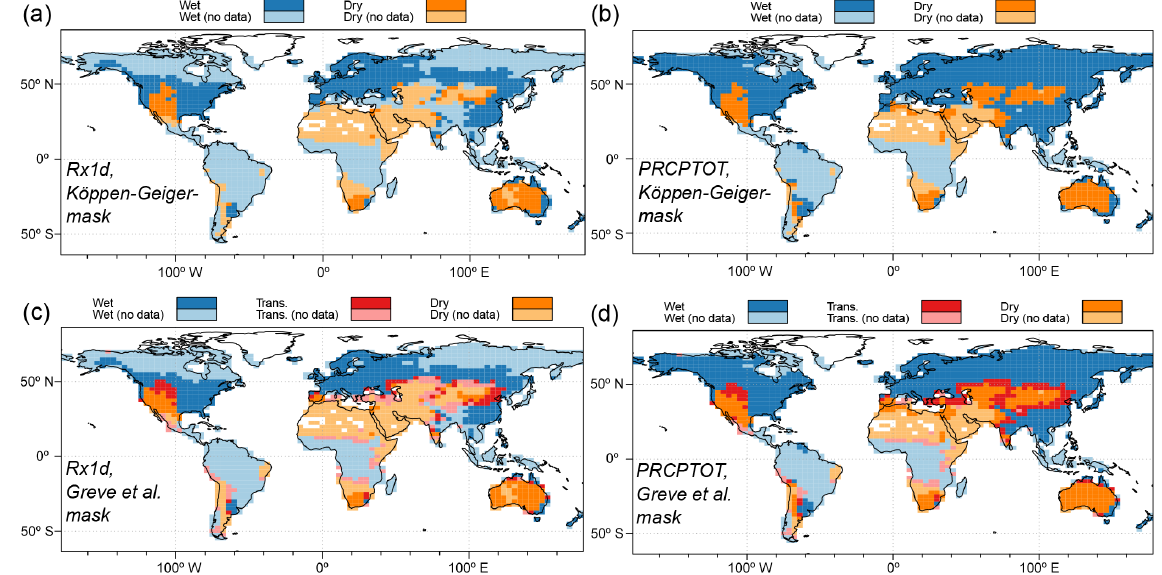
Figure B2. Available data in the HadEX2 dataset (Donat et al., 2013a) merged with GHCNDEX (Donat et al.,